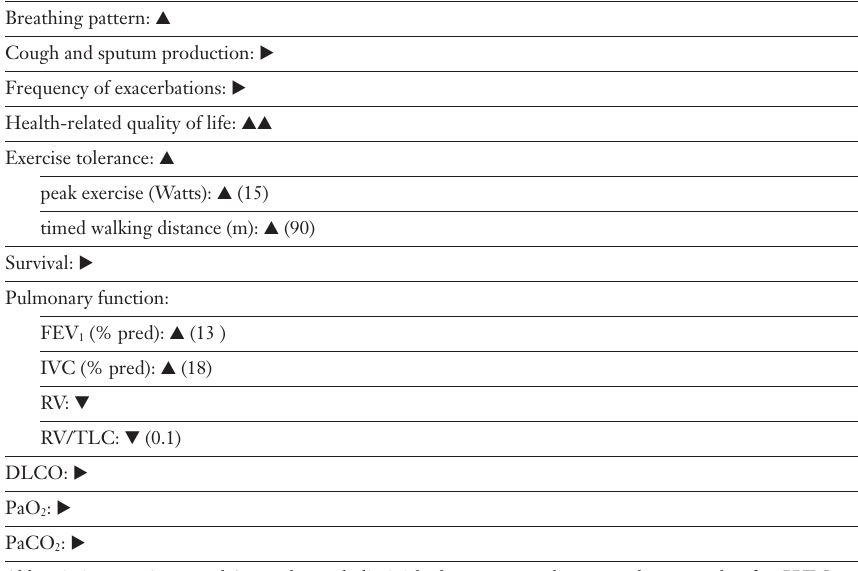
Table 2 Changes after LVRS in patients with severe